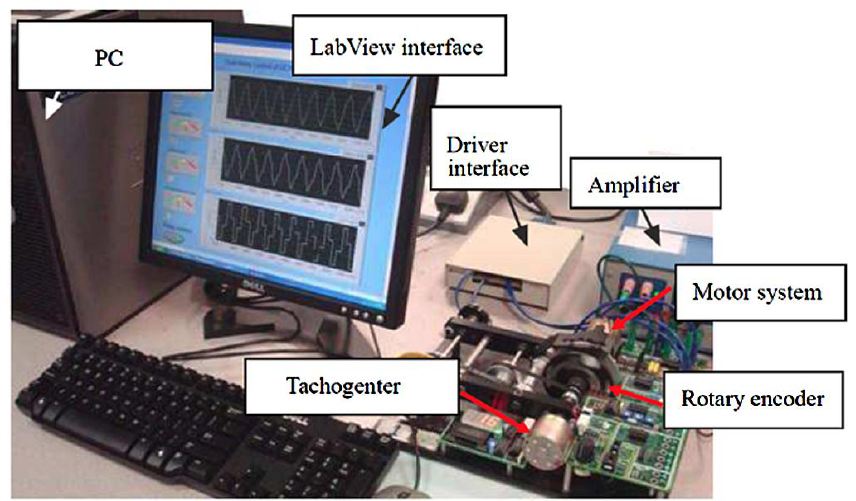
Figure 2. Sketch of the motor